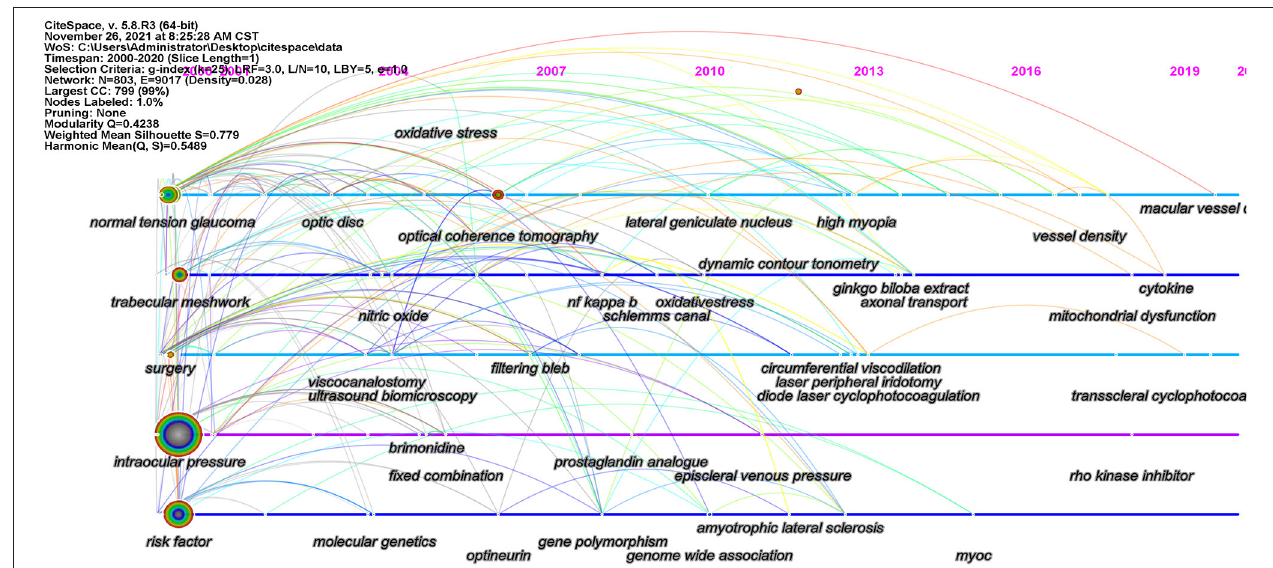
FIGURE 6 | Evolutionary pathway in the study of POAG: The position of each node represents when it first appeared, and the lines between nodes represent relationships between keywords. The node colors represent different years, from cold to warm means period from 2000 to 2021. Bluish purple indicates the previous keyword, and red indicates the latest keyword. Longer colored segments indicate a larger reference time span. The flow of knowledge between clusters from cool to warm colors can also be observed over